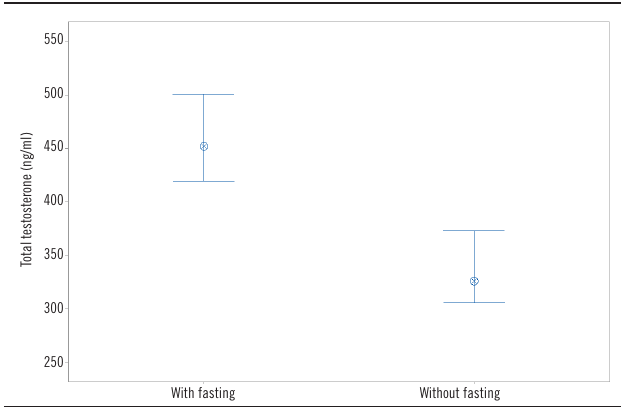
FIGURE 1 – Distribution of median values of total testosterone with collection participants